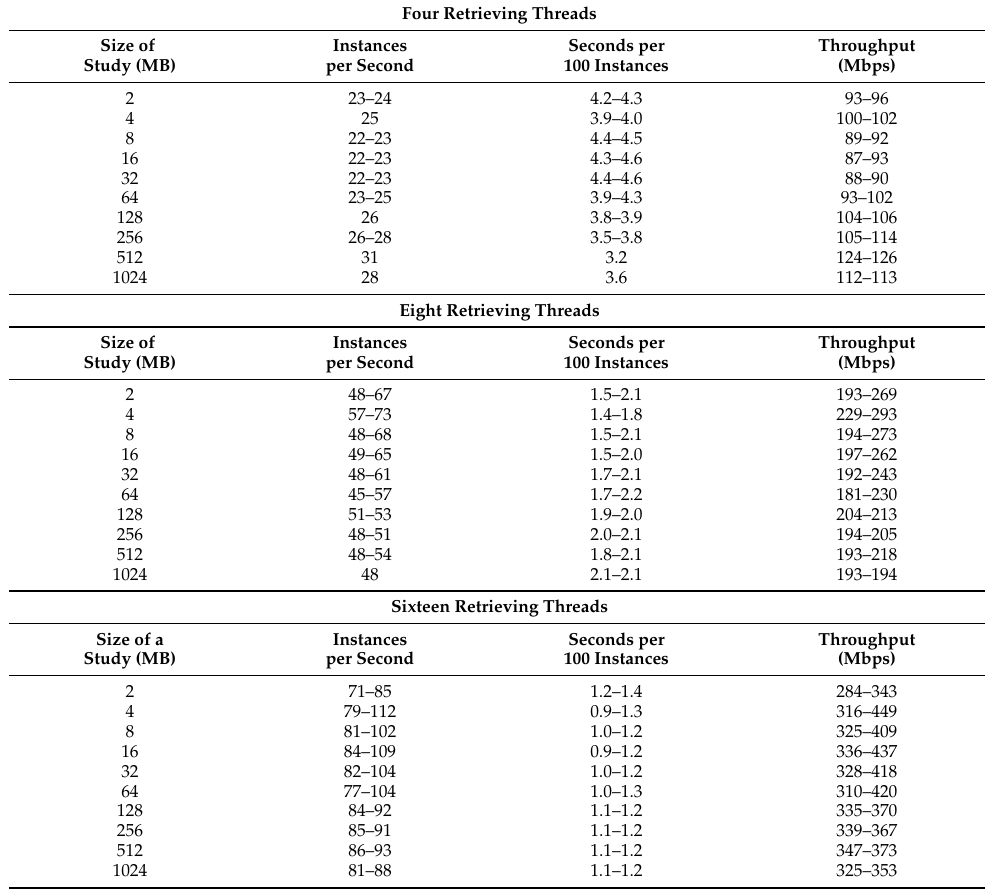
Table 4. Data retrieval test from studies of various sizes. A selected number of retrieving threads were started with a series of C-MOVE operations issued for each study. Retrieval was finished when the last operation of the final thread was completed. The range of obtained results (worst and best case) is